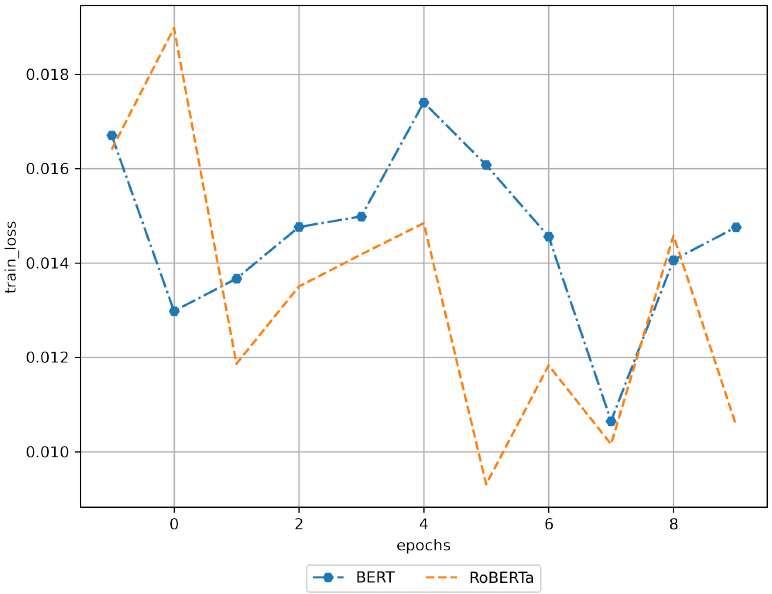
Figure 4. Evolution of the training_loss of neural networks devoted to filling in the blanks during the training